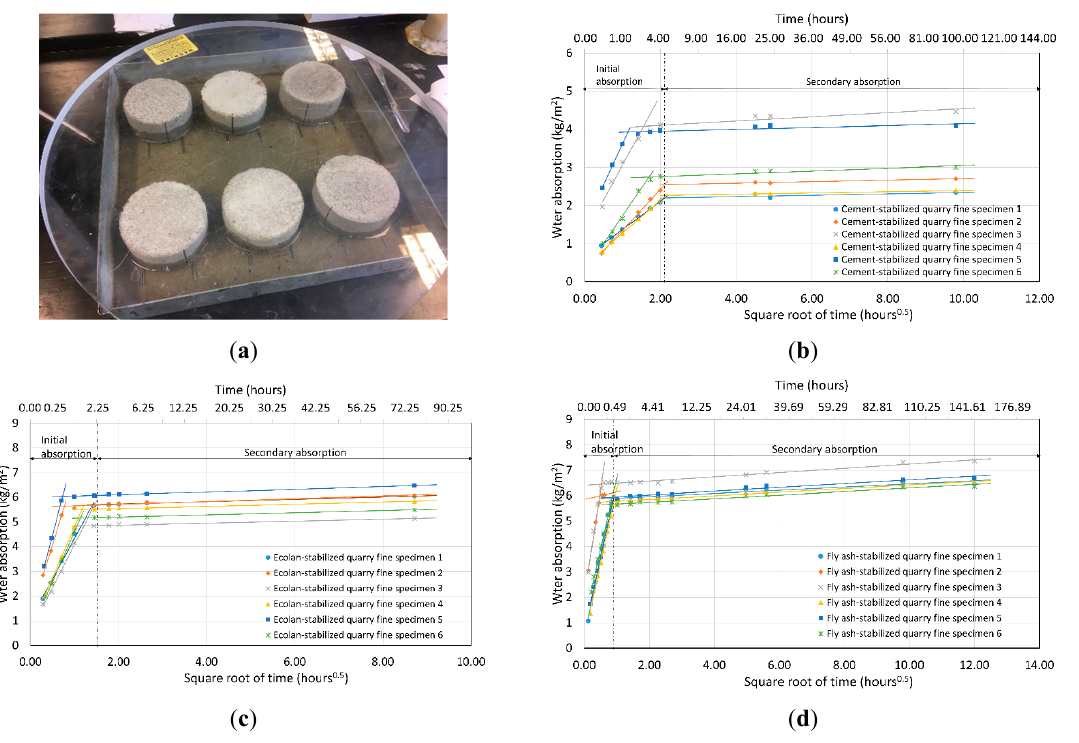
Figure 1. Capillary rise test: ( a ) specimens in one group; ( b ) water absorption of cement-stabilized quarry fines; ( c ) water absorption of Ecolan-stabilized quarry fines; ( d ) water absorption of fly ash-stabilized quarry fines.